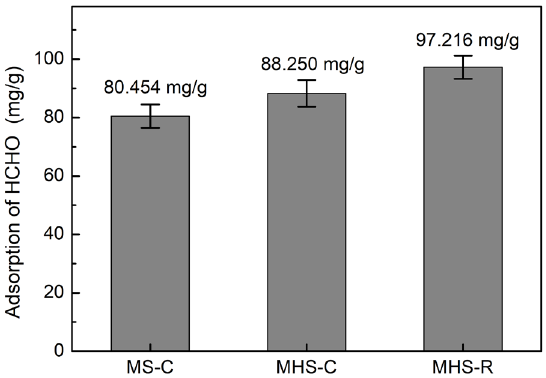
Figure 6. Formaldehyde adsorption results for mesoporous silica and mesoporous hollow silica materials.